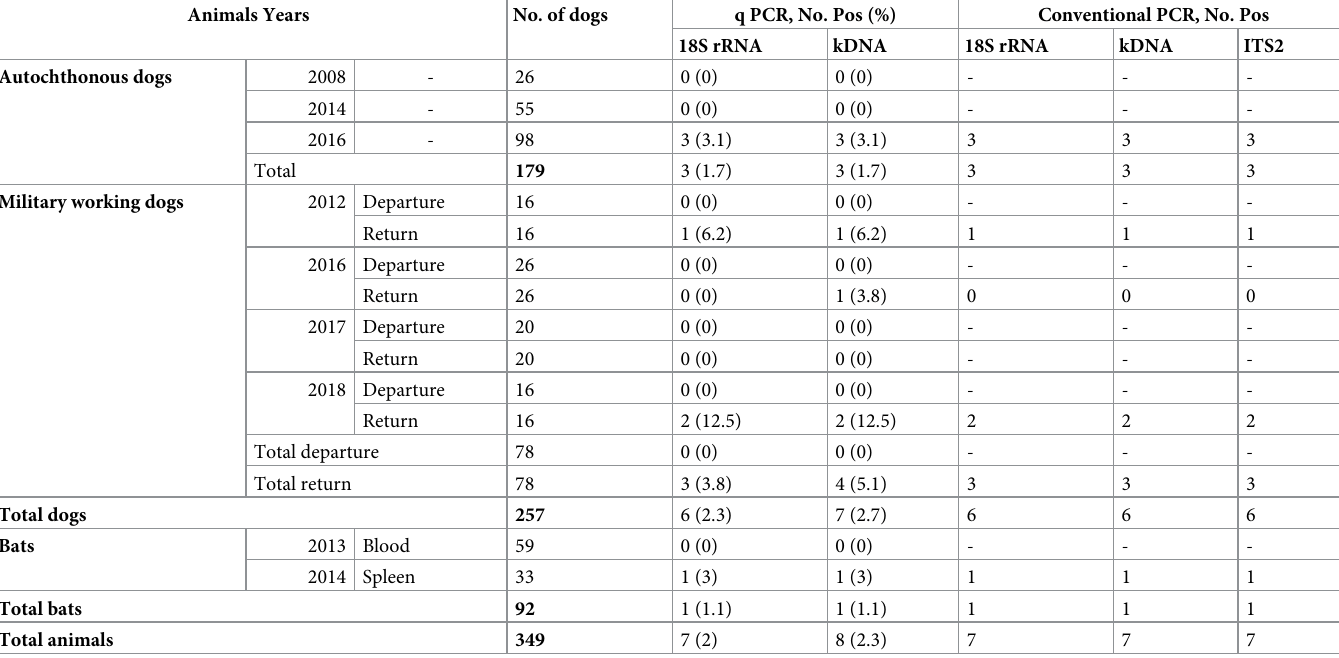
Table 2. Molecular results for surveyed animals.